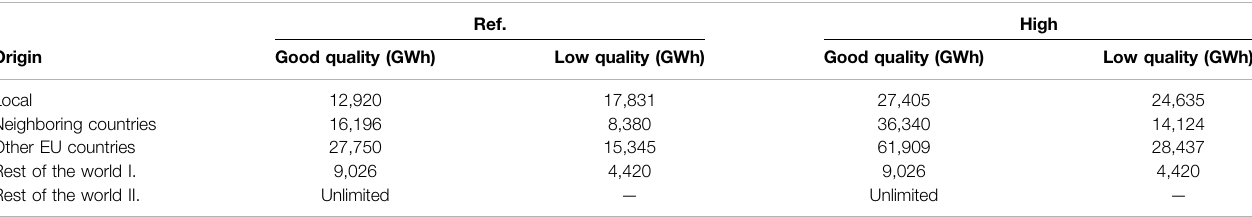
TABLE 1 | Distribution of the lignocellulosic feedstock by origin and quality categories (in GWh) for the reference and high potential scenarios.